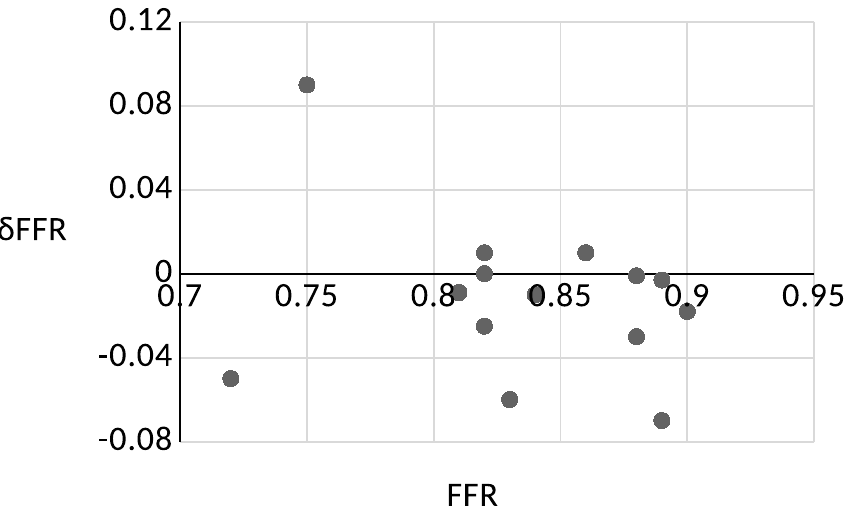
Figure 7. Difference between the FFRs, which were calculated for the full trees by the recursive algorithm, and measured